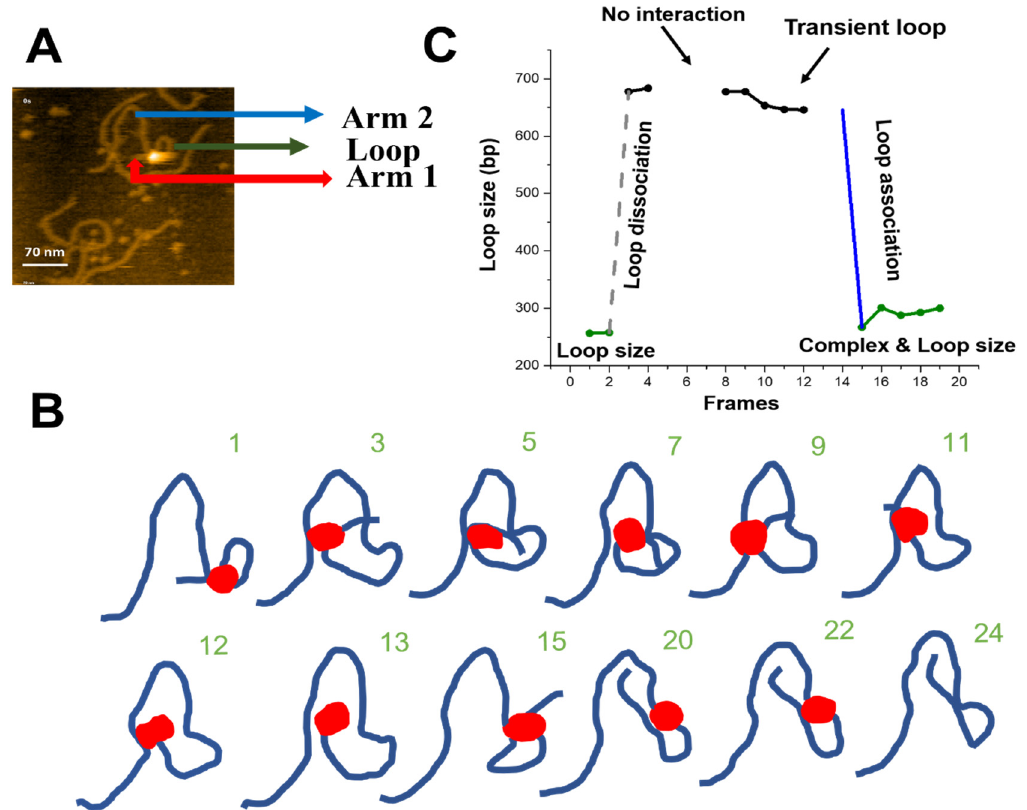
Figure 5. Site-bound segment transfer mechanism of SfiI. ( A ) Initial frame of Movie S4. The sfiI tetramer is the bright feature at the center of the loop structure. The loop structure is indicated with a green arrow, the small DNA arm (Arm 1) is shown by a red arrow, and the long DNA arm (Arm 2) is labeled with a blue arrow. ( B ) Traces of the synaptic complex from selected HS-AFM movie frames; numbers indicate frames. Raw images are shown in Figure S3. ( C ) Loop size change in bp ± SE versus frame number. The green indicates the loop size of the synaptic complex. Grey indicates the dissociation of the loop complex. Black indicates transient